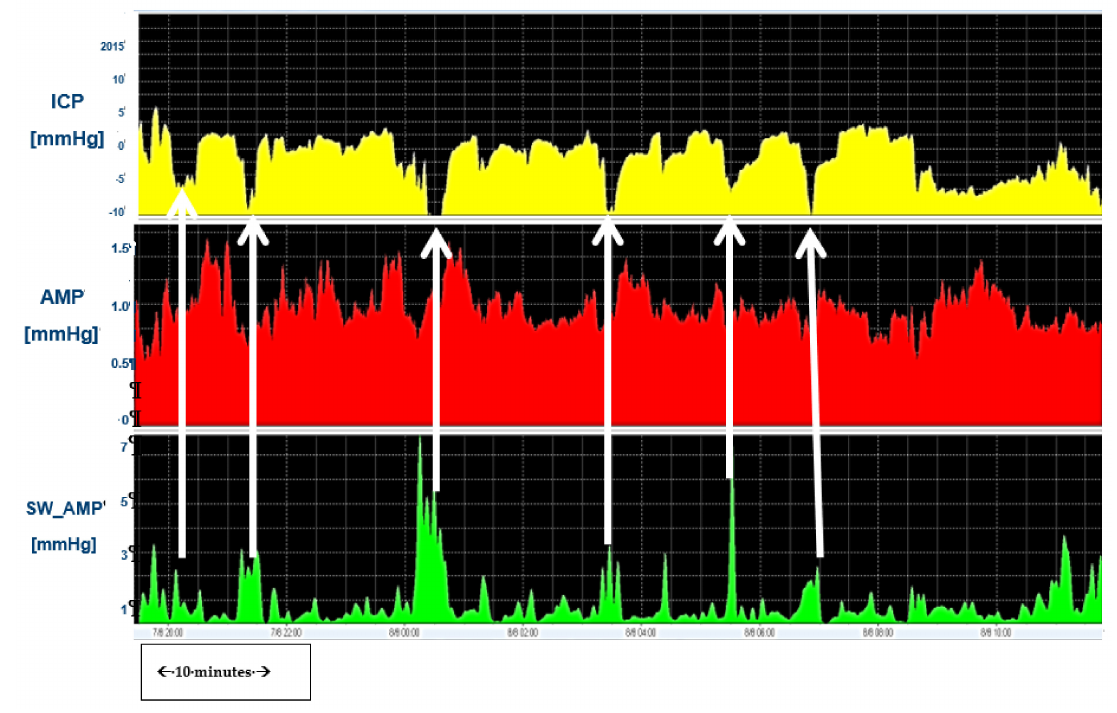
Figure 7. Illustration of CSF over-drainage related to strong slow wave activity. Frequent ICP slow waves (b-waves) as shown in this case (green), result in respective frequent opening of the shunt and drainage of CSF. Subsequent abrupt dips in ICP (yellow) down to a level of − 10 mmHg corresponding to the opening and drainage of the shunt valve. A constantly open shunt valve can subsequently cause significant over-drainage Red illustrates changes in pulse amplitude of ICP (AMP). SW_AMP: slow wave amplitude.